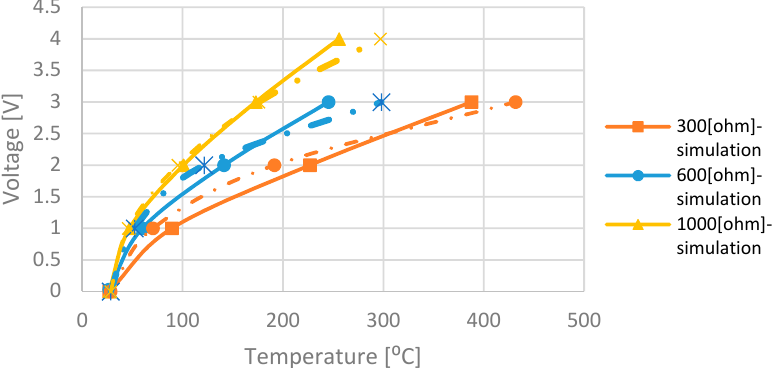
Figure 11. Simulation (solid lines) and measurements (dashed lines) results. Applied heater voltage vs. the average hot-plate temperature for di ff erent heater resistor. Note: Measured temperatures for high heater voltages (4–5 V) were ignored in this figure because the sub-threshold assumption is not valid at